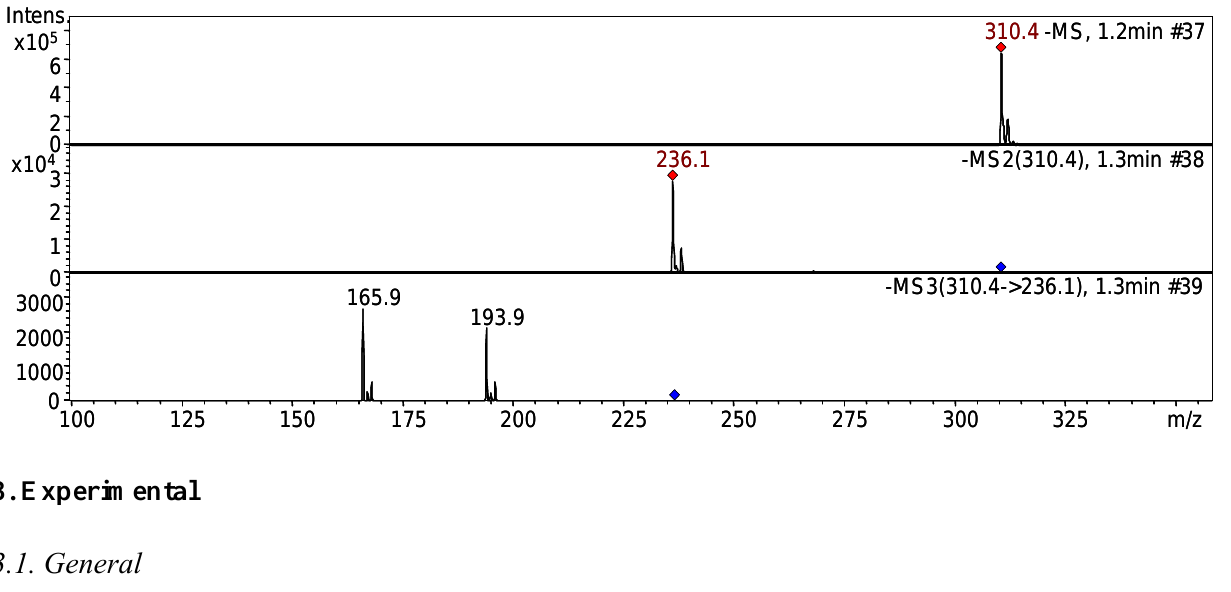
Figure 1. ESI MS spectra of N "-[(3 Z )-1-acetyl-5-chloro-2-oxo-1,2-dihydro-3 H -indol-3- ylidene]thiocarbonohydrazide ( 4